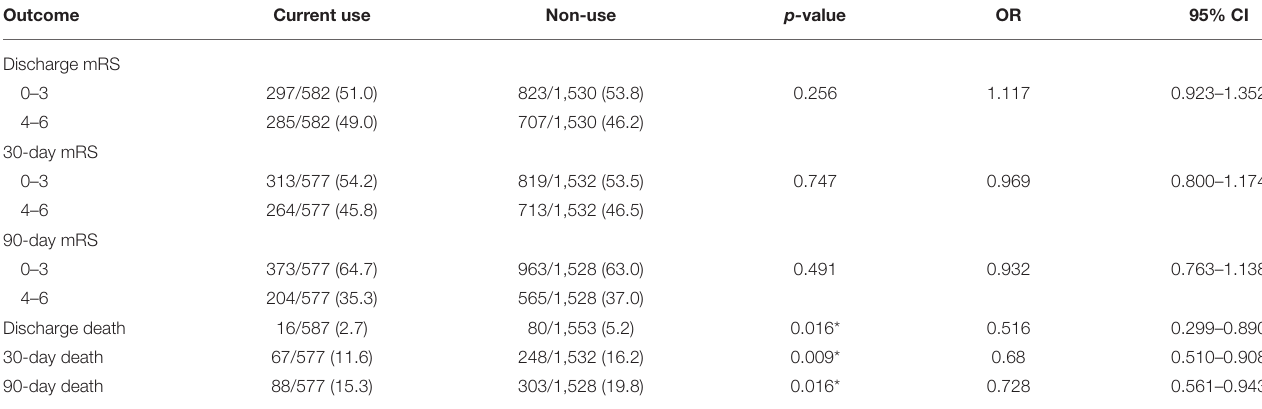
TABLE 2 | Clinical outcomes of the